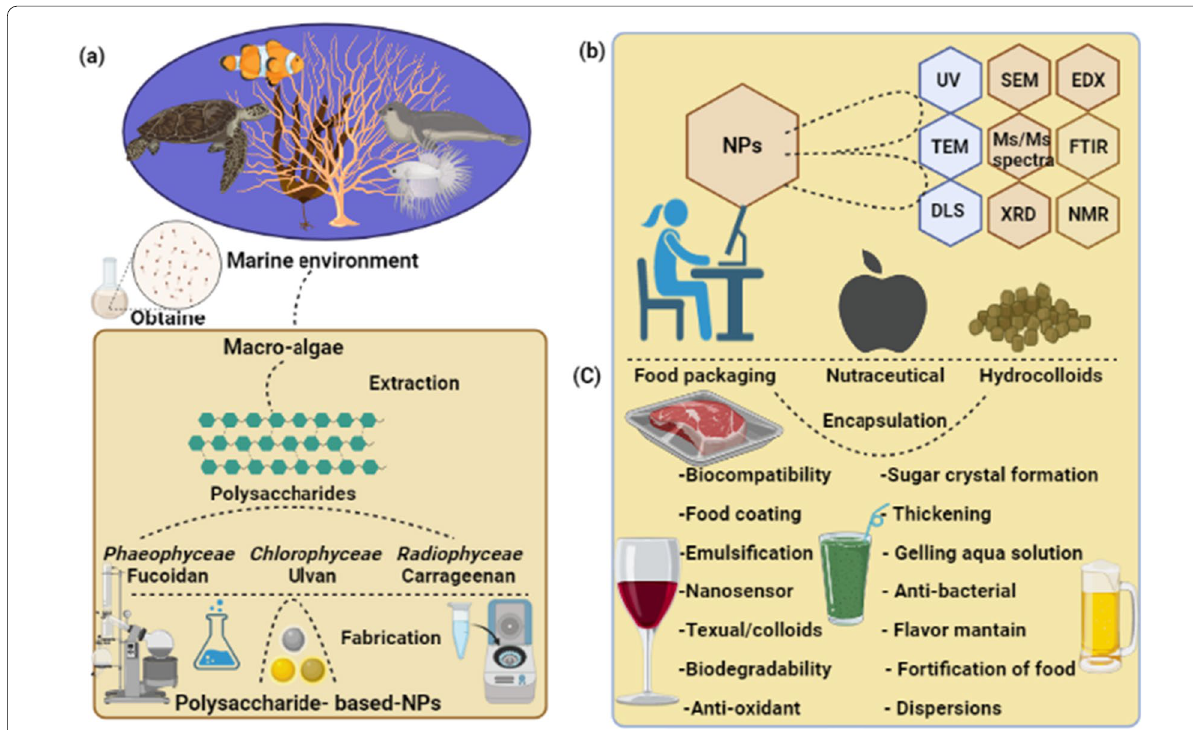
Fig. 5 Marine macroalgae polysaccharides extraction and its application in food